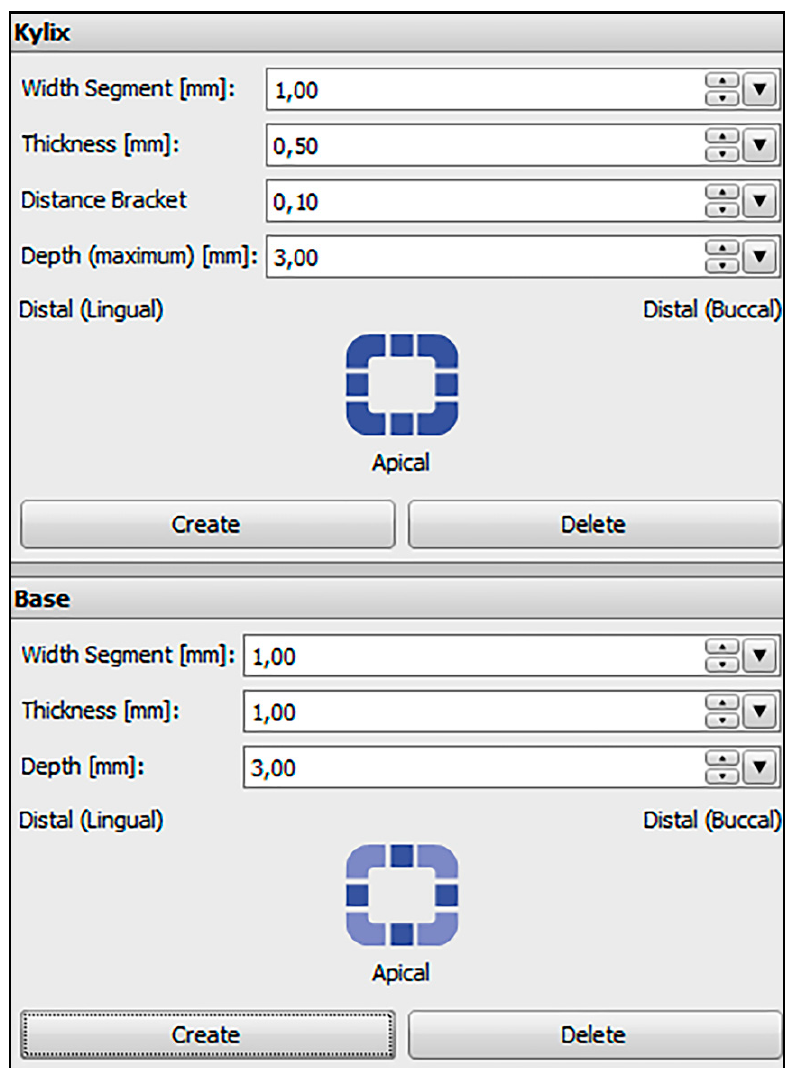
Figure 2. Parameters used in the OnyxCeph 3 ™ Kylix 3D module (Image Instruments, Chemnitz, Germany).